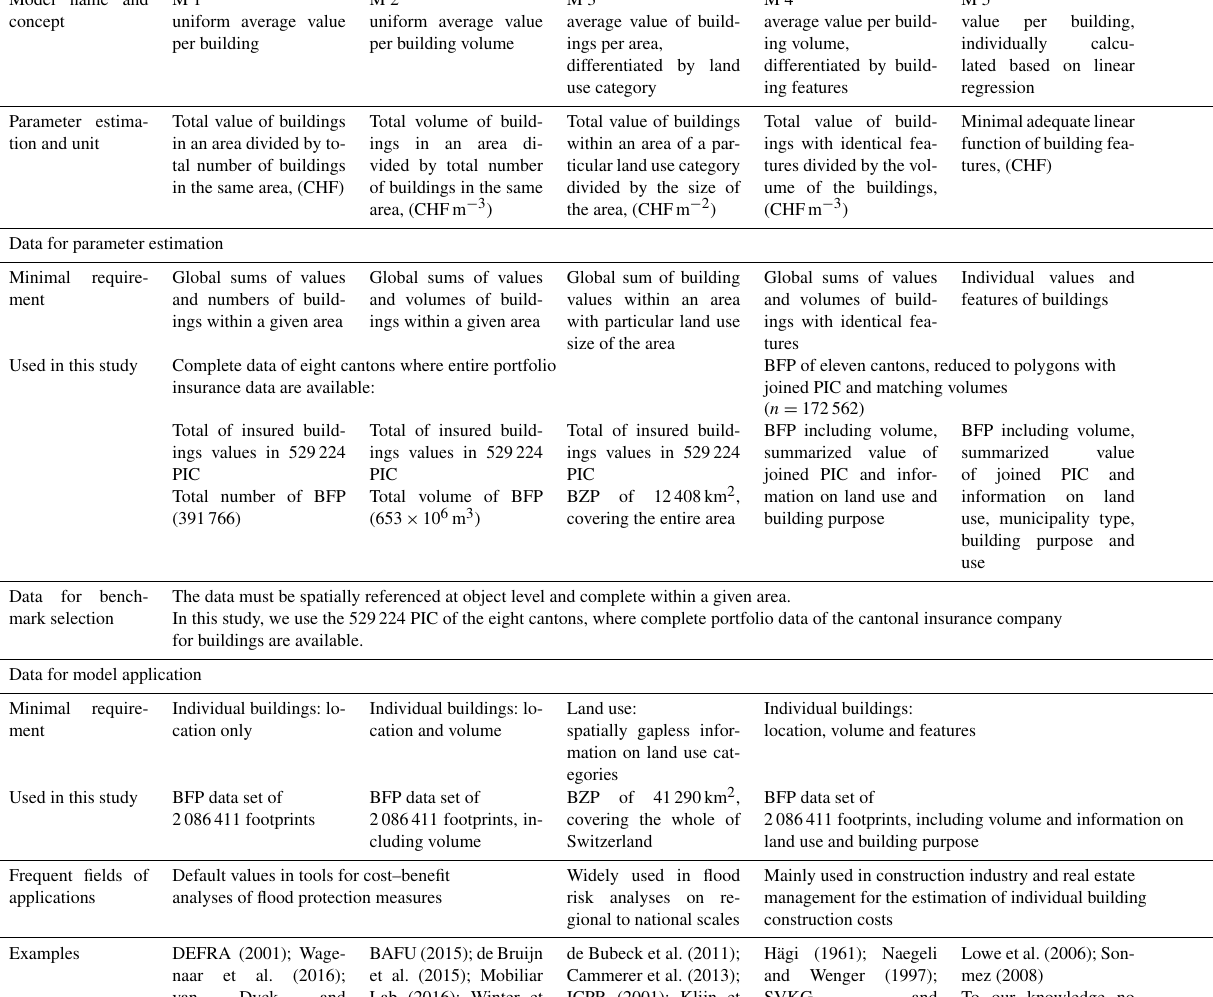
Table 1. Overview of concepts, data and applications of the five investigated models for building value estimation. BFP stands for building footprint polygons, BZP for building zone polygons and PIC for points of insurance